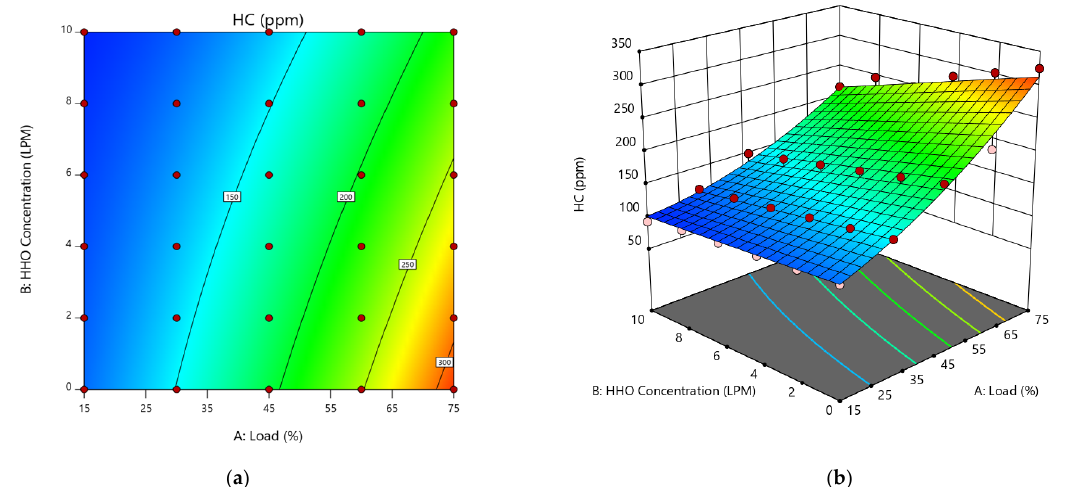
Figure 9. ( a ) Contour plot and ( b ) response surface of HC.